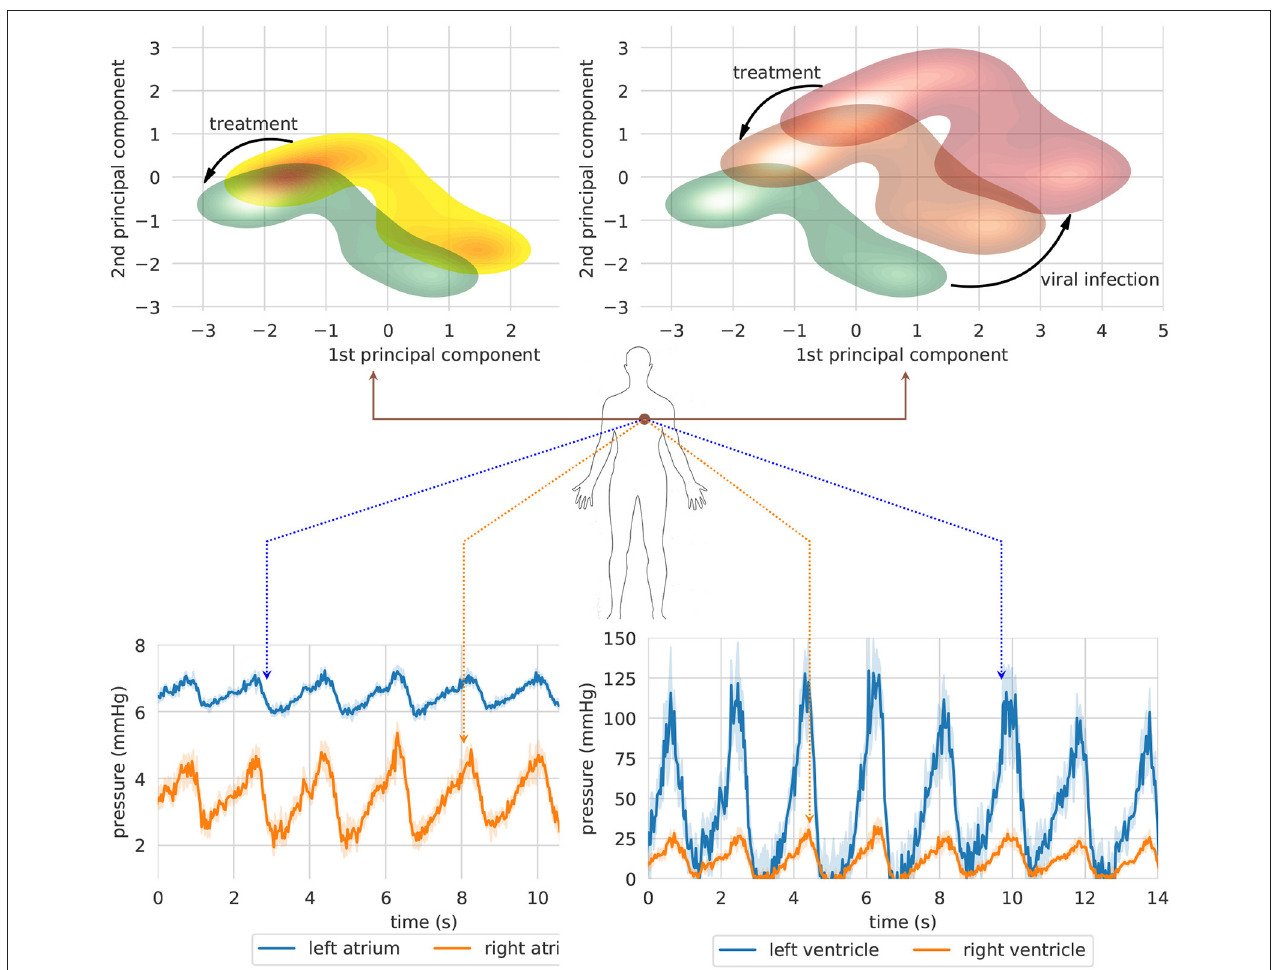
FIGURE 5 | Two clinical case studies represented in a projected heart phase-space. The first case study (left) shows the effect of a therapeutic intervention comprising an increased physical exercise, a reduced amount of calorie intake, and the subscription of a daily dosage of Benazepril (5 mg). The second simulation (right) shows the long-term impact on blood pressure of an untreated SARS-CoV-2 infection (red density) and the effects of a therapy including both Benazepril (5 mg/day) and intra venous injection of heparin (5000 µ /ml) (orange density). (Top) Bundle of predicted trajectories can be visualized and monitored in real time in order to investigate patterns in the time domain. The simulation shows blood pressure in heart chambers starting from healthy state conditions. Error bands represent 95% CI